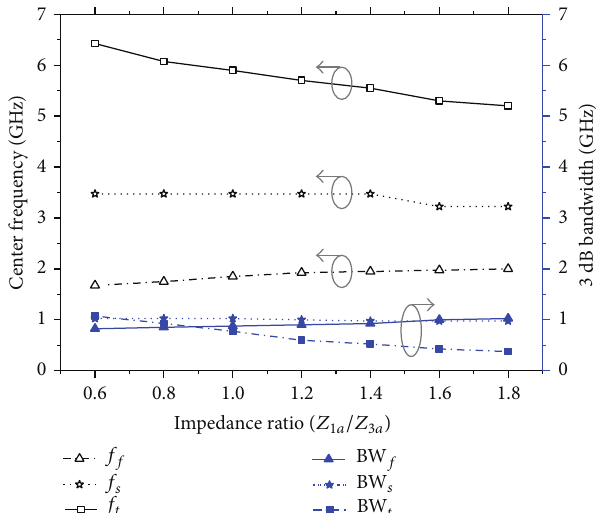
Figure 5: Plot of the variations of the center frequencies and bandwidths of the TBBSF versus the varied impedance ratio for the proposed TSSIR 𝑎 shows that 𝑓 𝑓 , 𝑓 𝑡 and BW 𝑓 , BW 𝑡 can be controlled at almost constant 𝑓 𝑠 and BW 𝑠 , respectively.